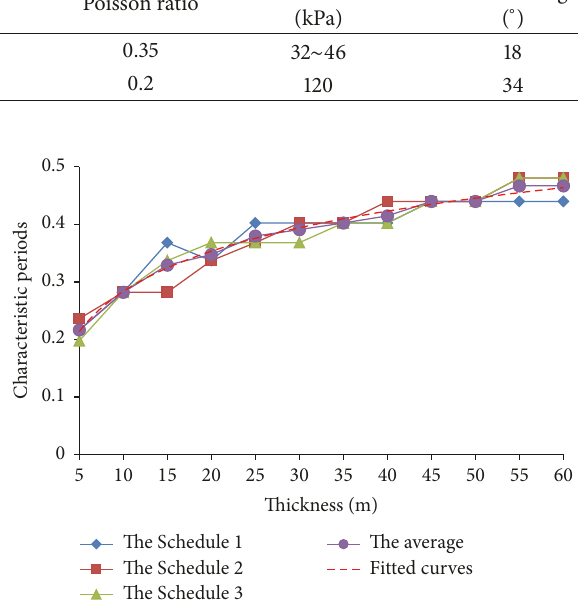
Figure 6: The distribution of the characteristic